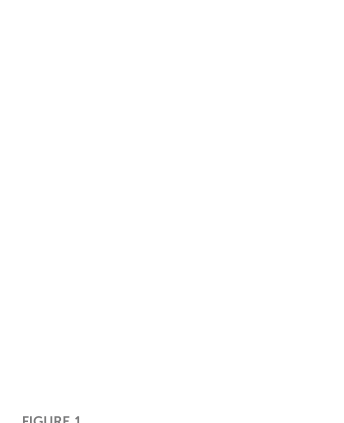
FIGURE 1 Chemical structures of